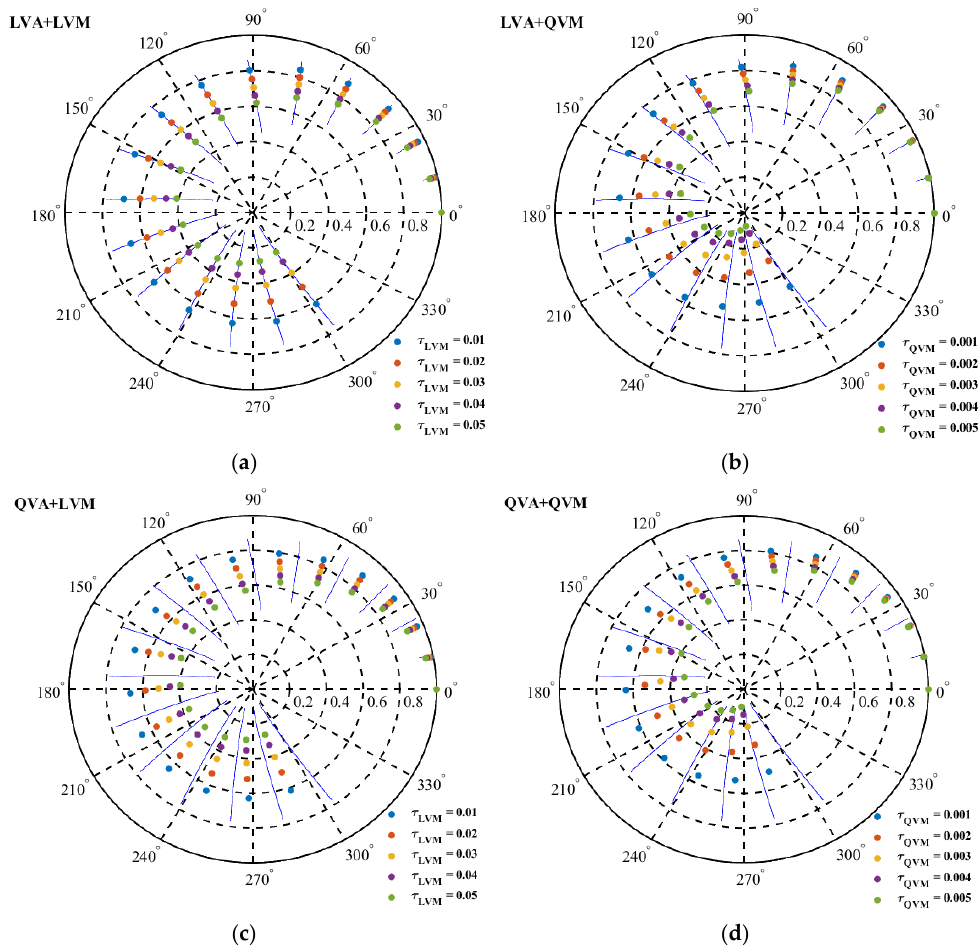
Figure 6. Volumetric coherence varying with different random motion coefficients: ( a ) LVA + LVM; ( b ) LVA + QVM; ( c ) QVA + LVM; ( d ) QVA + QVM.